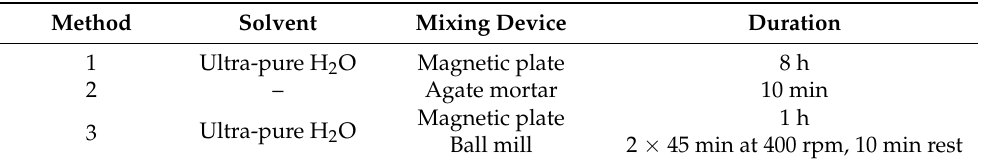
Table 1. Summary of the mixing